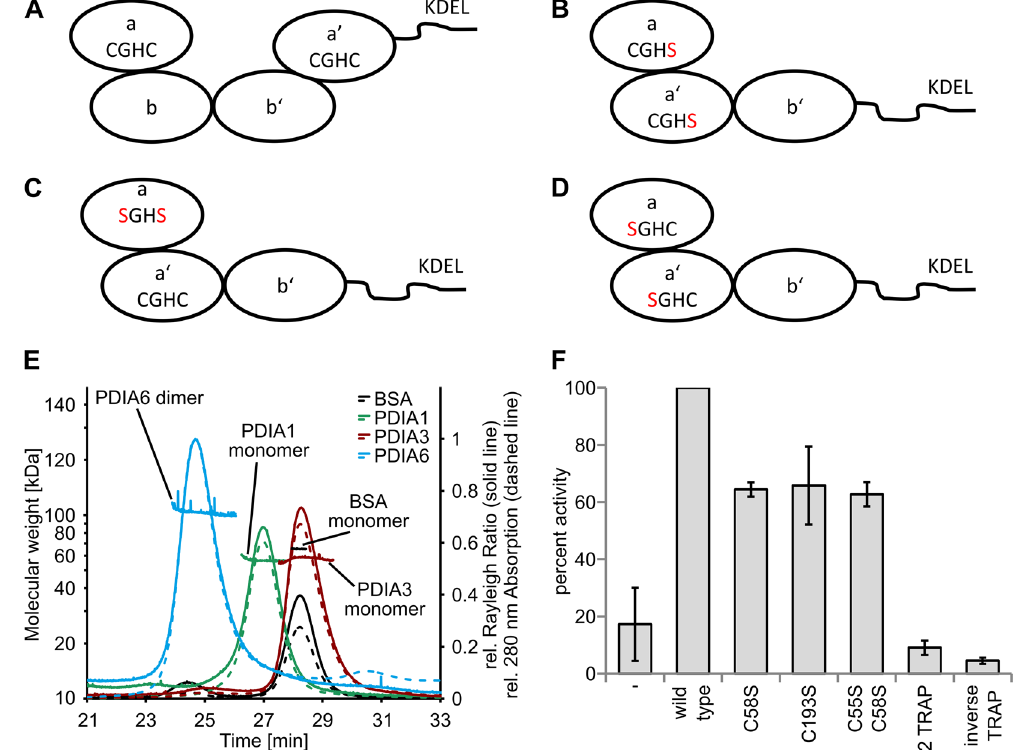
Figure 4. ( A ) Schematic drawing of the domain arrangement of PDIA1 and PDIA3 in which the CGHC- motive of the catalytically active sites are indicated. ( B ) Schematic domain arrangement of the 2 TRAP mutant of PDIA6, where both C-terminal cysteine residues of the CGHC-motive are exchanged to serine residues. ( C ) Schematic drawing of the C55SC58S mutant and ( D ) the inverse TRAP mutant bearing exchanges in the N-terminal cysteine residues of the CGHC-motive. ( E ) Chromatograms of the SEC-MALS analysis of PDIA1, PDIA3, PDIA6 and BSA as control. Shown is only the relevant section of the complete elution profile (60 minutes at 0.5 ml/minutes) of the detected absorption at 280 nm (dashed line) and the Rayleigh ratio (solid line, derived from MALS) normalized to PDIA6. In addition, the calculated molecular weight for each slice of the analyzed peaks is shown. ( F ) Comparison of the activities of indicated TRAP mutants relative to wild-type PDIA6 whose activity was set to